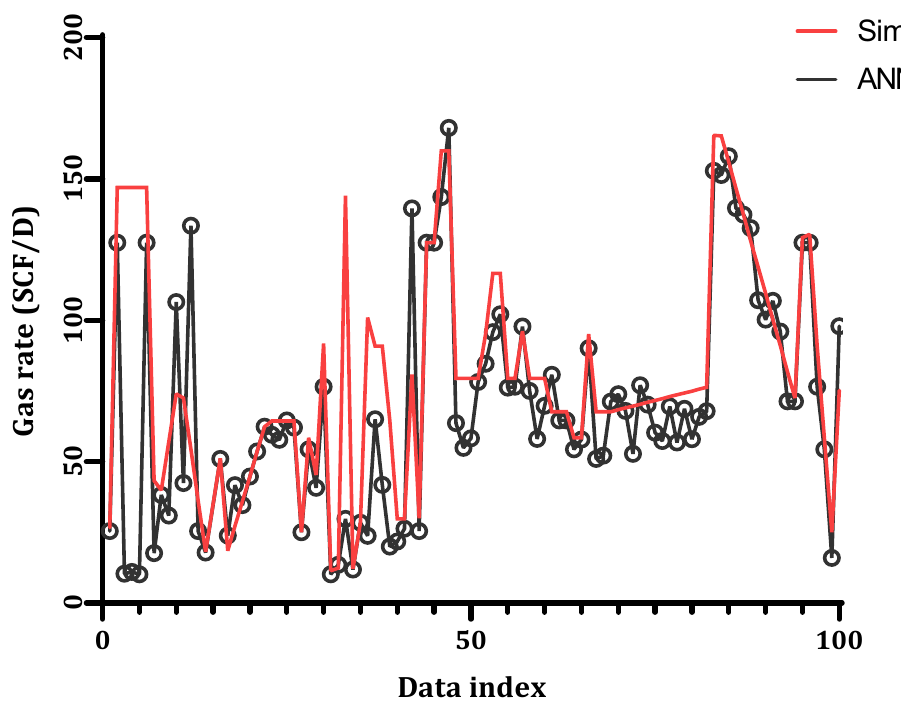
Figure 16. ANN gas flow rate vs. simulated gas flow rate.